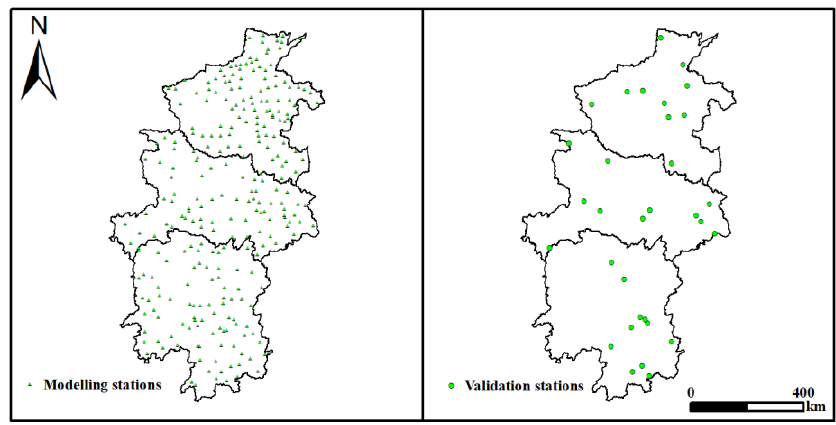
Figure 2. Spatial distribution of meteorological observation stations in the central part of China (269 modelling stations; 28 validation stations).